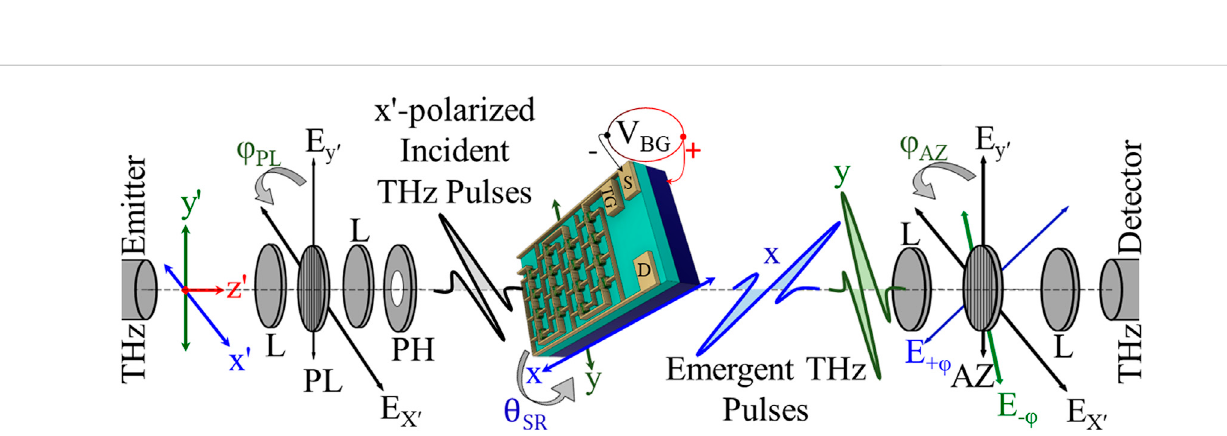
Figure 4A. Single pulse transmission analysis provides all together comparison with the simulations and yields a direct evidence of the resonance supported by the SRs. By considering all the Fabry-Pérot resonances, it is possible to infer the device ’ s behavior under a THz continuous wave source. Pulses passing through a 1.2 × 1.2 μ m 2 uniform graphene patch fabricated on-chip without any SRs metal features are used for normalization, i.e. E ref. . Unwanted absorption